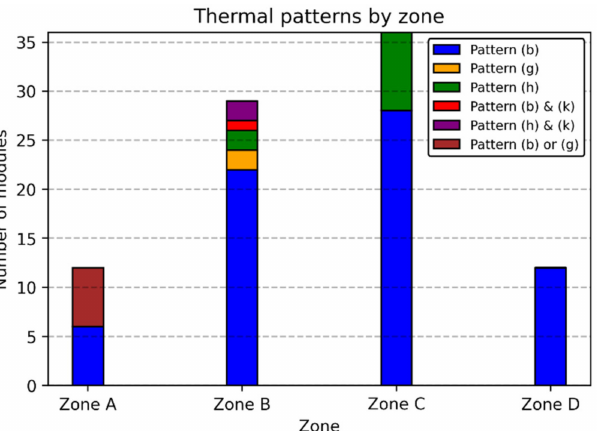
Figure 13. Thermal patterns found within 89 PV modules. Modules are sorted by zone.